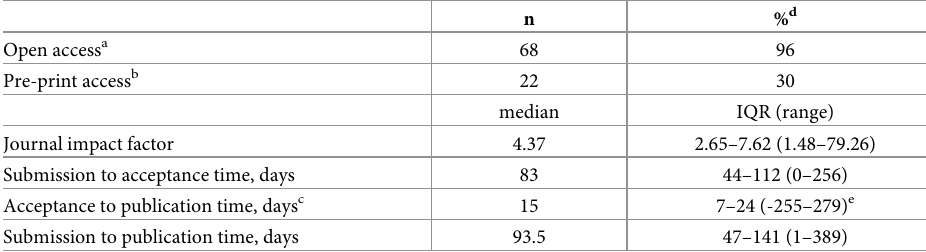
Table 3. Accessibility, timeliness and other bibliometrics of eligible